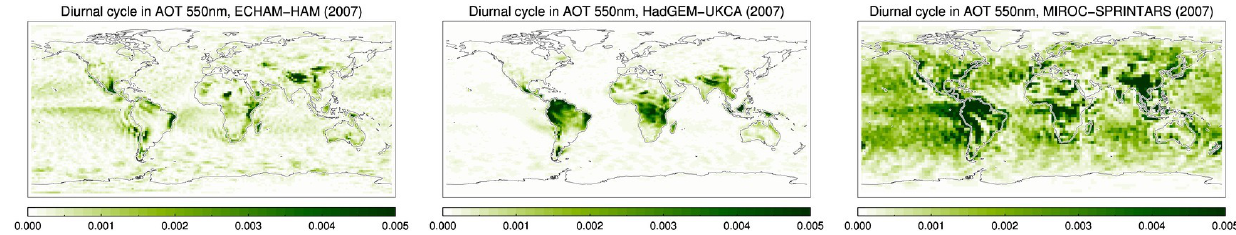
Figure 4. Global maps of the relative importance of the diurnal cycle: the ratio of power at a period of 1day to total power for AOT time series.